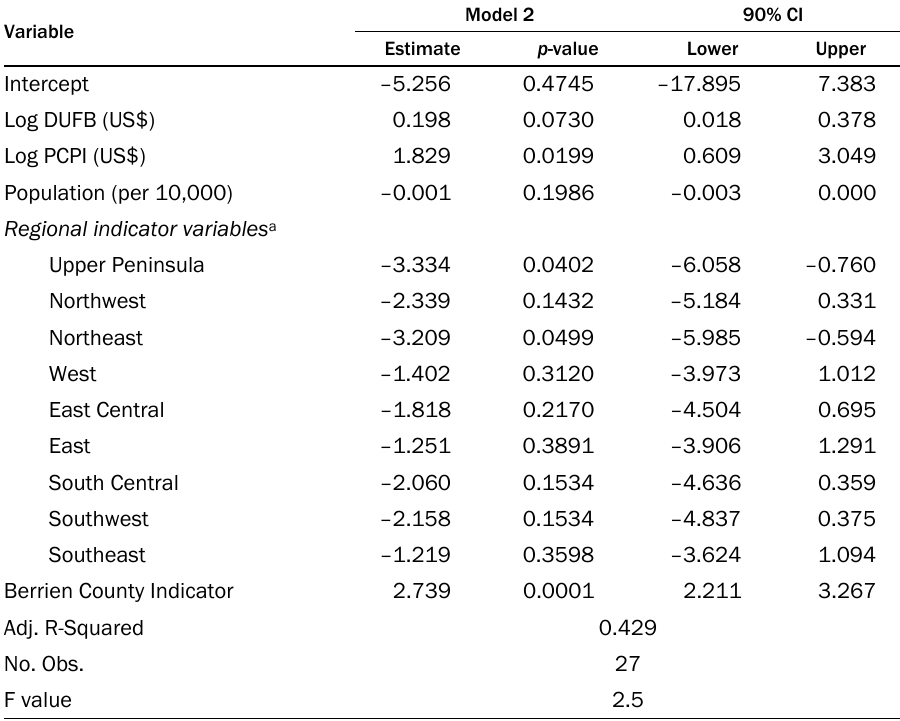
Table B1. Regression Results for Log Direct Sales Model 2,